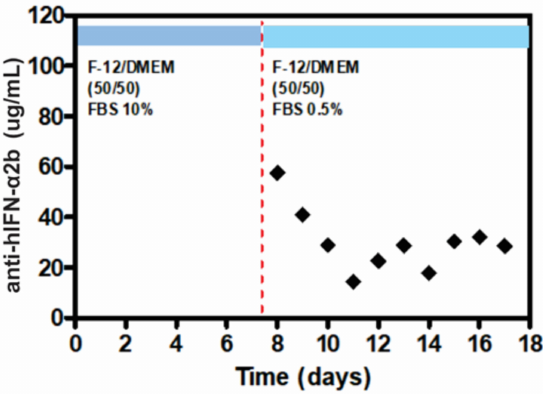
Figure 6. Concentration of anti-hIFN- α 2b monoclonal antibody in supernatants of large-area mi- crofluidic bioreactor culture from day 8 to day 18 of production is shown in black